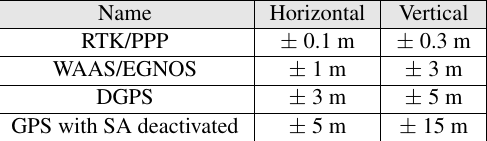
Table 1: Typical accuracy in different GPS receivers